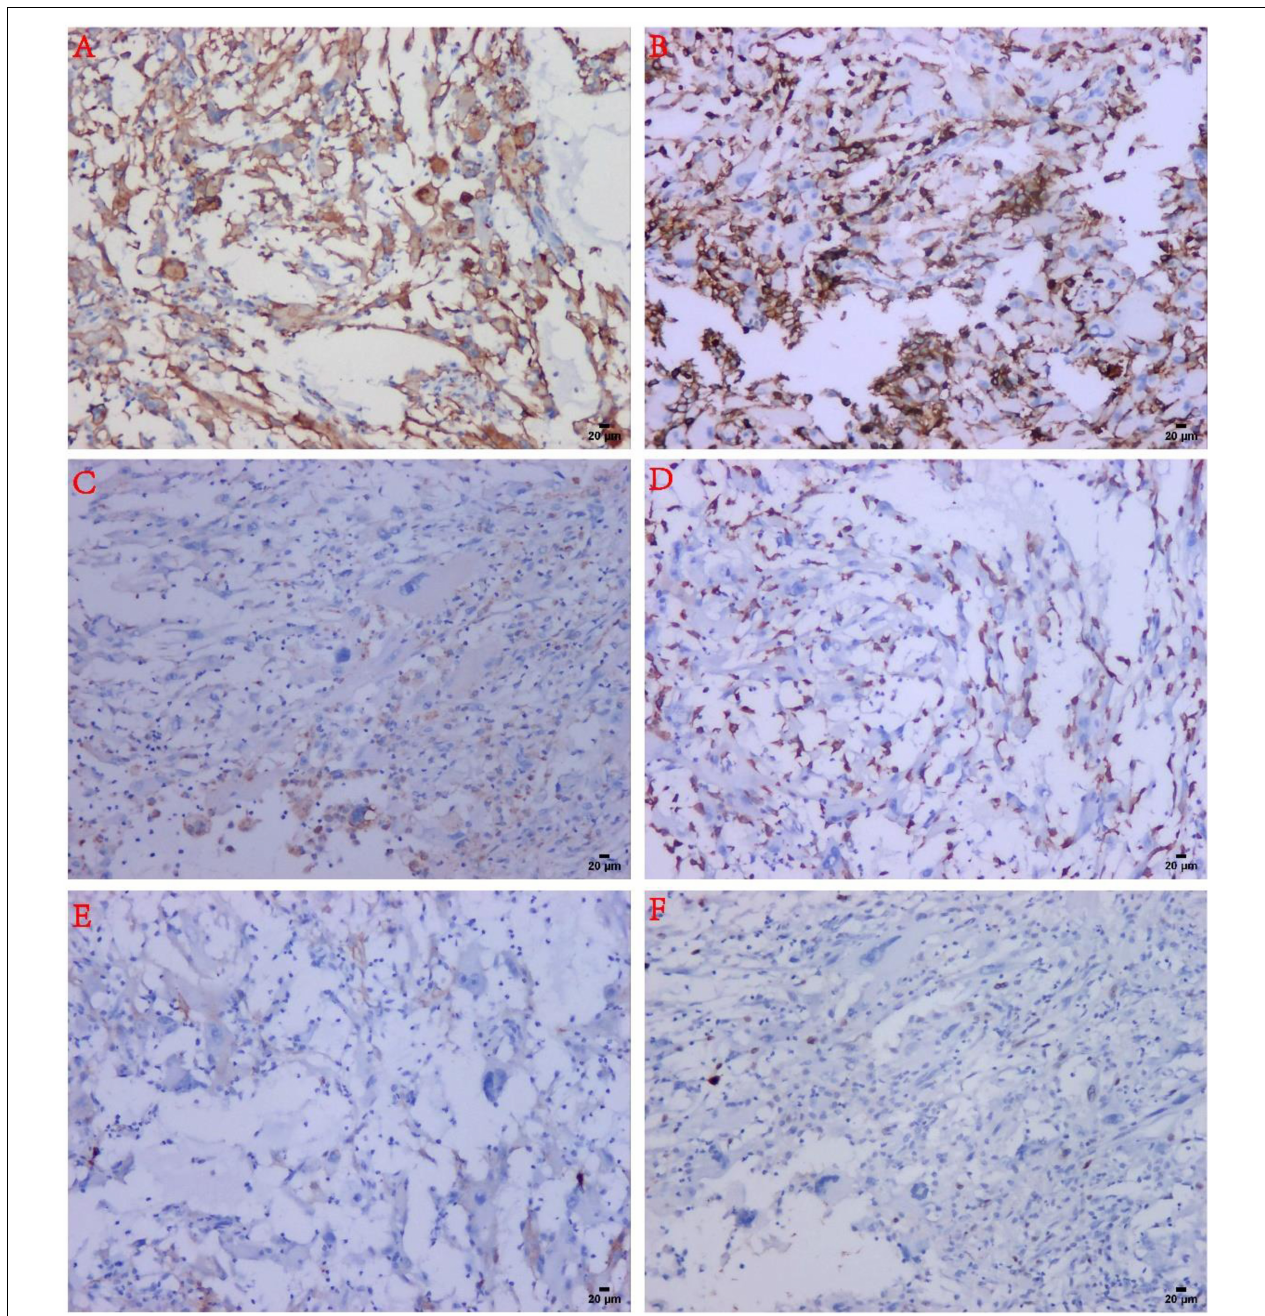
FIGURE 4 | Immunohistochemical findings in MIFS. (A) The tumor spindle cells and malformed cells were strongly positive for CD10. (B) Infiltrated inflammatory cells were strongly positive for LCA. (C) The reactive histiocytes were positive for CD68. (D) Reactive histiocytes were positive for CD163. (E) The tumor cells were negative for D2-40. (F) The tumor cells expressed low-proliferative Ki-67 (about